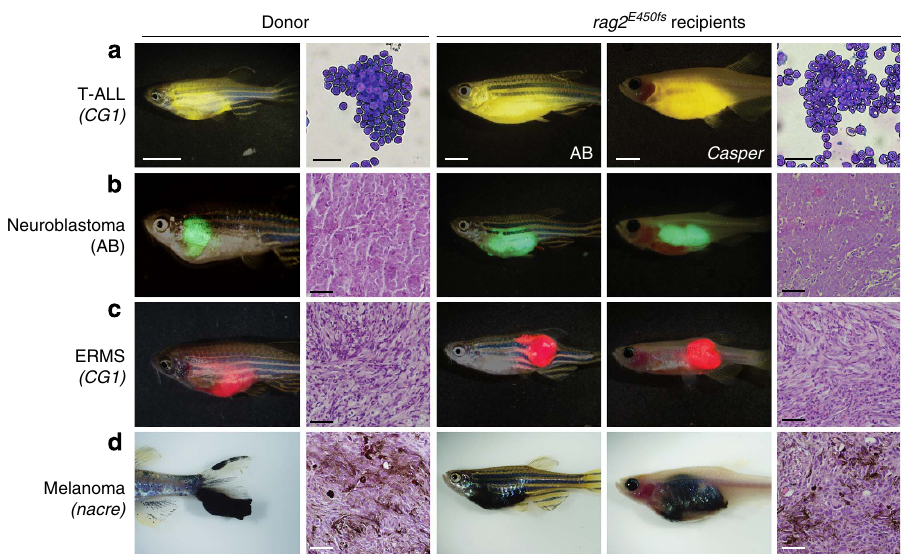
Figure 1 | Zebrafish cancers engraft into homozygous rag2 E450fs (casper) animals. Donor animals shown in the left two panels while transplant recipients are to the right. ( a ) ZsYellow-labelled Myc -driven T-ALL from the syngeneic CG1 background, ( b ) EGFP-labelled neuroblastoma from AB background, ( c ) mCherry-labelled kRAS G12D - driven ERMS from CG1 background, and ( d ) BRAF V600E -induced melanoma arising in tp53 (cid:2) / (cid:2) nacre background. Tumour cells were transplanted intra-peritoneally ( a , b , d ) or intra-muscularly ( c ) into both rag2 E450fs (AB) and rag2 E450fs (casper)- recipient fish. Merged brightfield and fluorescent images are shown at 30 d.p.t. Cytospins of leukaemia cells are shown in a , whereas haematoxylin and eosin (H&E)-stained sections are shown in b – d . Scale bars equal 5mm in whole animals images, 20 m m for cytospins shown in a , and 50 m m for histology sections shown in b – d .